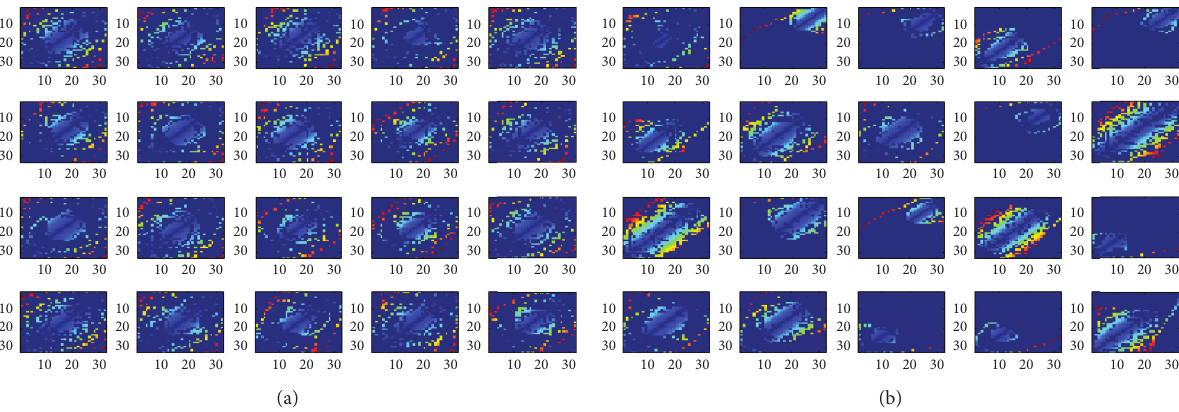
Figure 14: The similarity result of (a) FMPP and (b) rotation